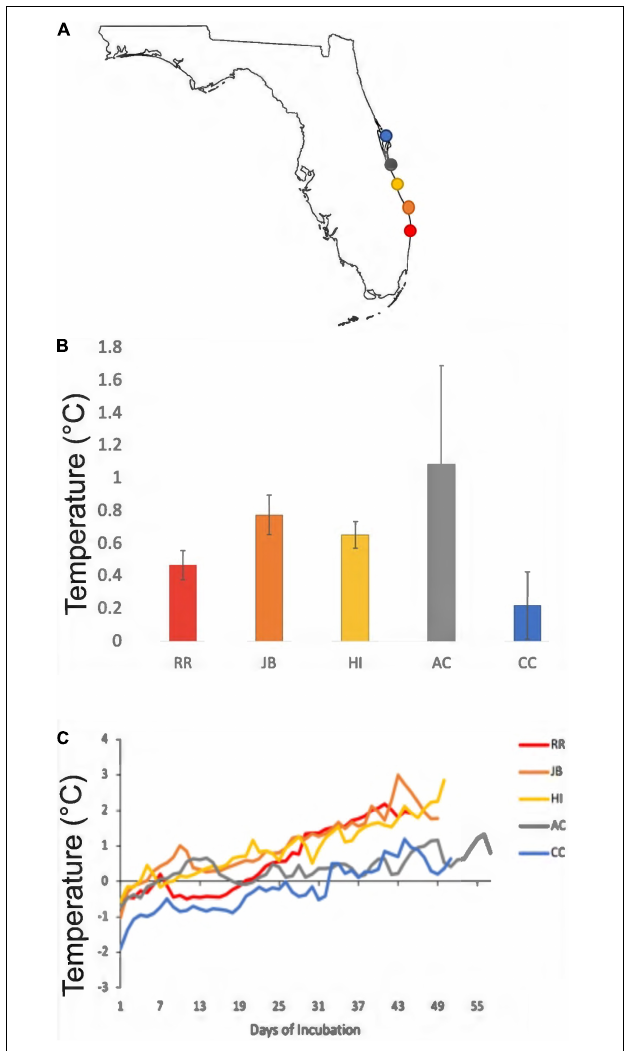
FIGURE 4 | Mean daily differences between internal clutch temperatures and control sand temperatures from the 2020 nesting season. (A) Gray and blue colors are the warm-temperate sites. Red, orange, and yellow colors are the subtropical sites. The colors are the same in (B,C) . (B) The mean temperature differentials between internal nest and control sand for each study site. Error bars represent 95% confidence intervals. (C) Differences between daily mean clutch and sand temperature throughout incubation durations (days). Note how nest temperatures exceed surrounding sand temperatures due to metabolic heating, and how metabolic heating is more pronounced in subtropical nests compared to warm-temperate